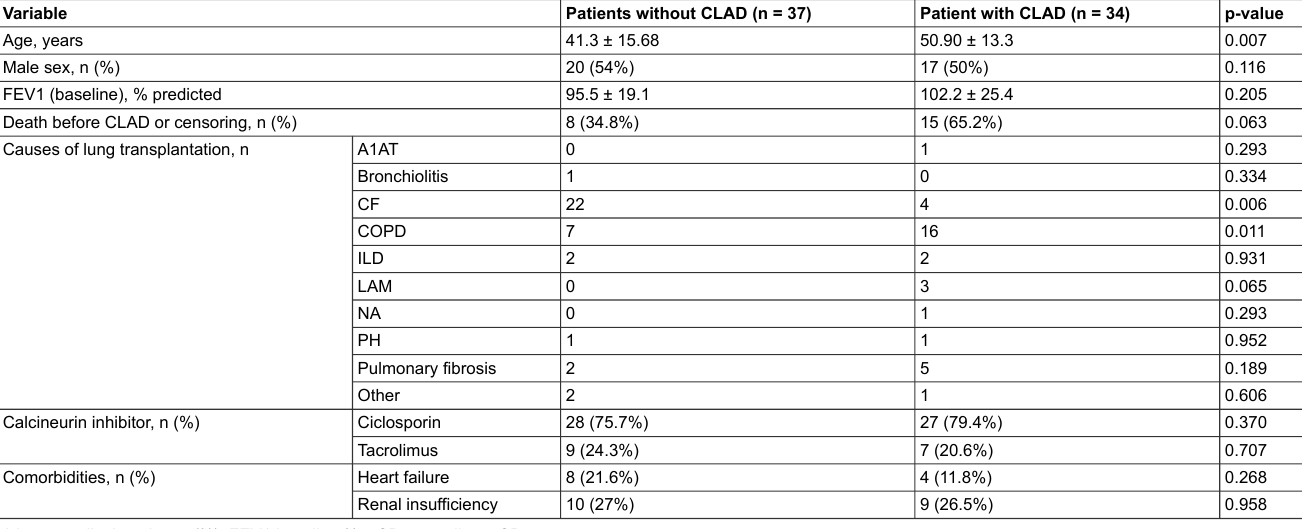
Table 1: Baseline characteristics of the main cohort.